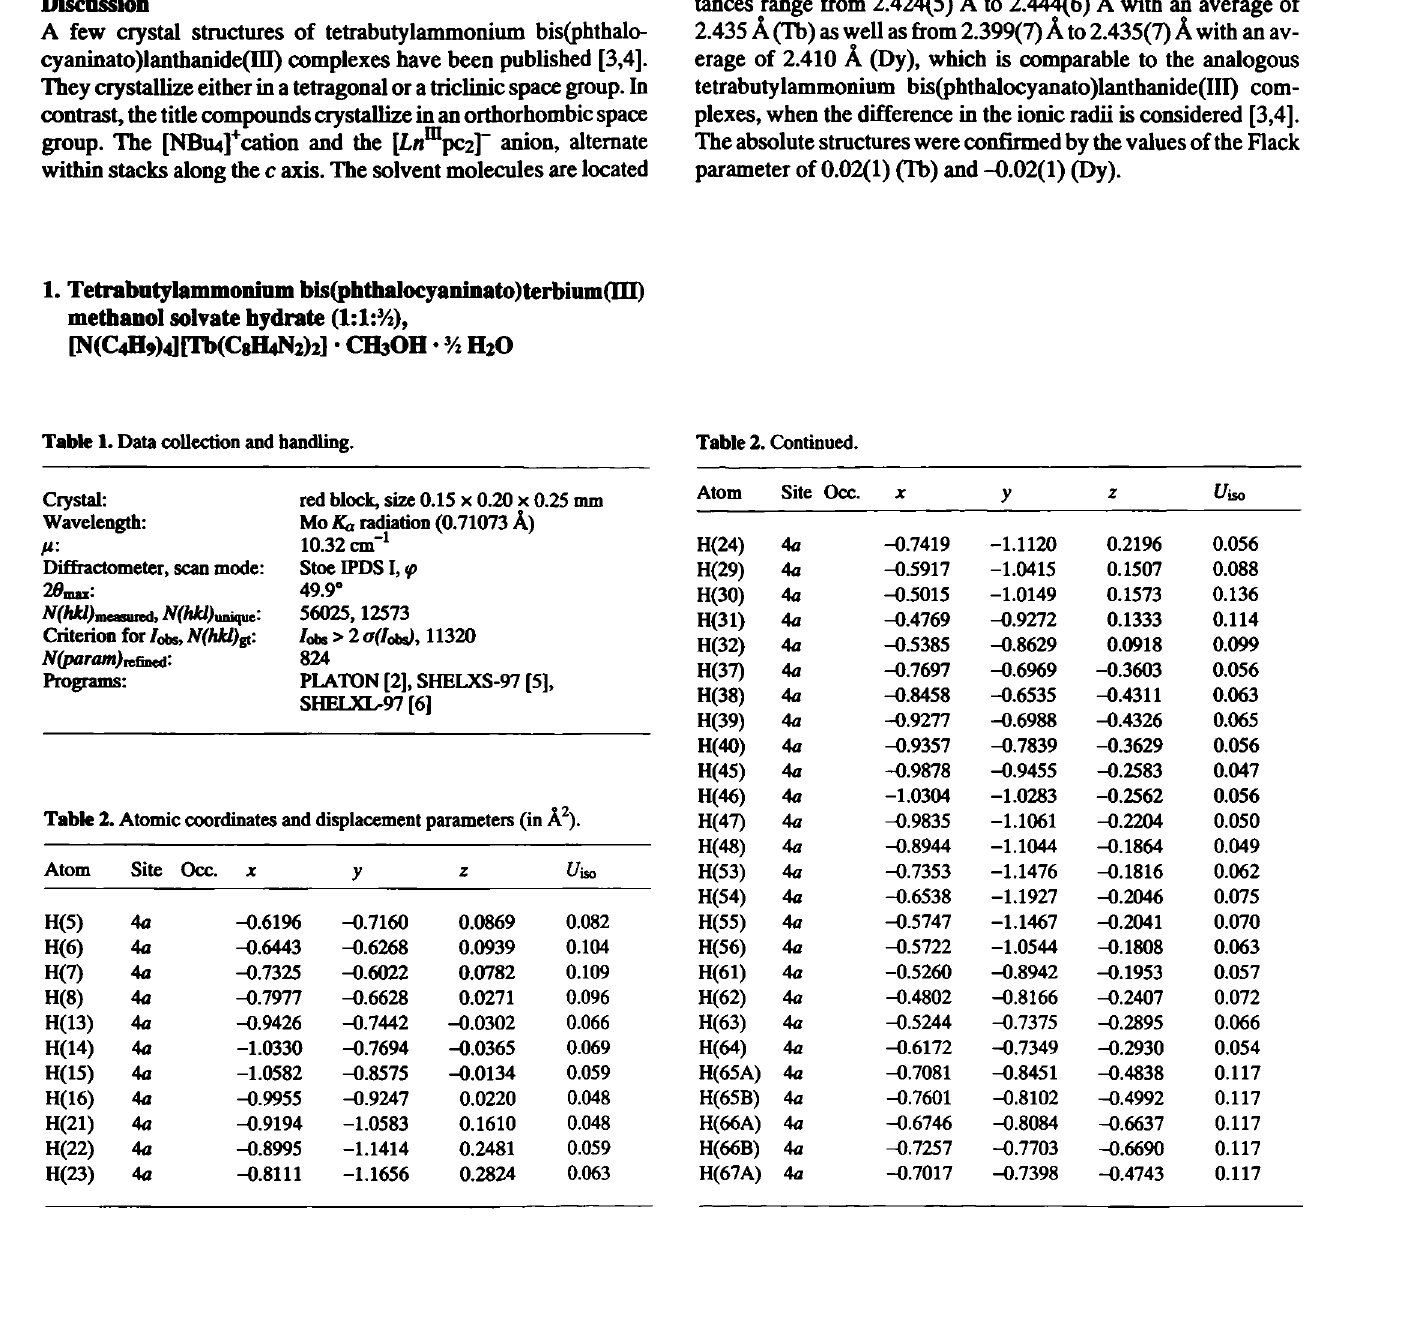
Table 1. Data collection and handling. Table 2. Continued.